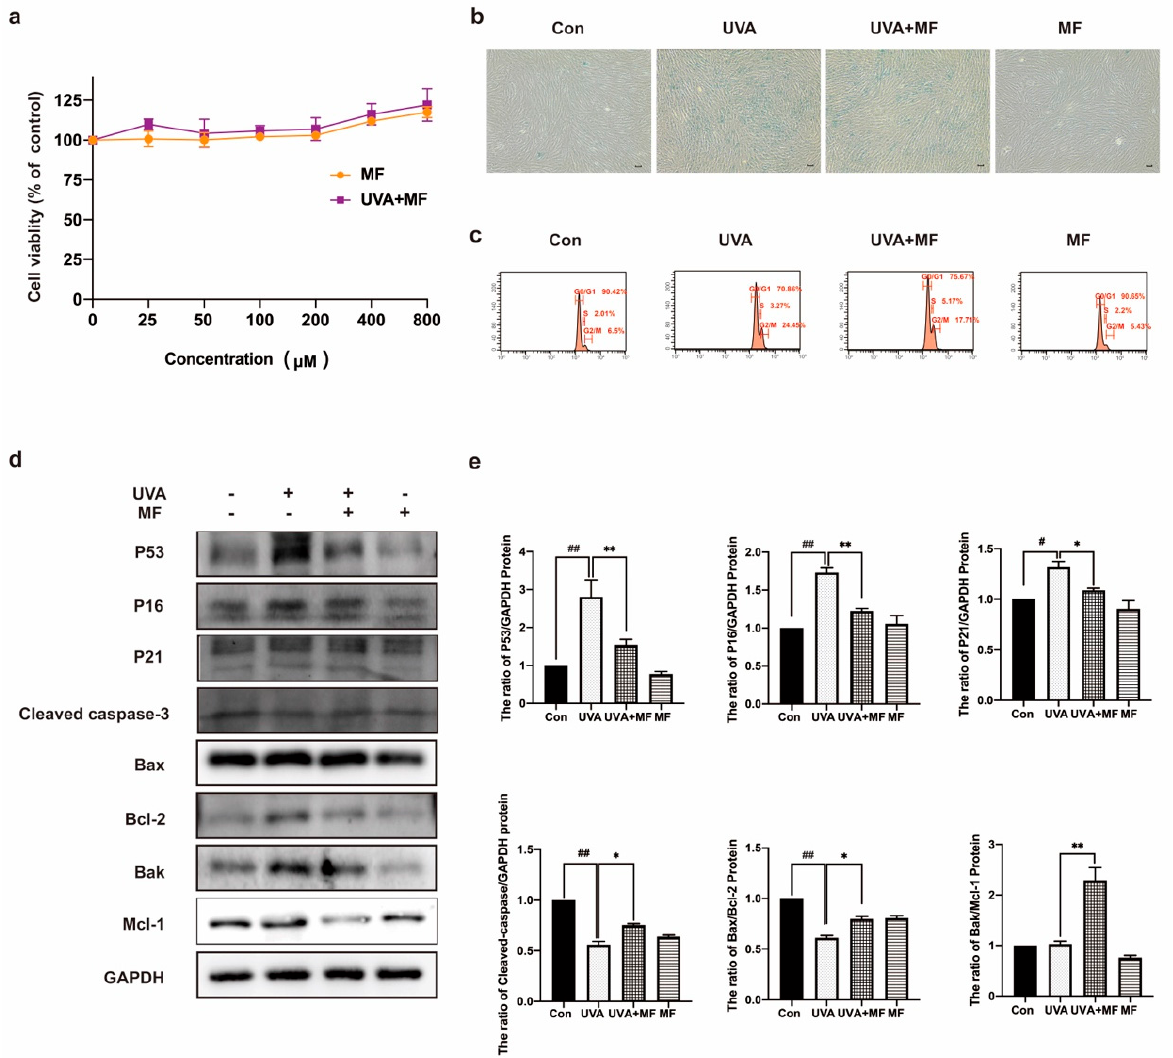
Figure 2. Metformin can ameliorate UVA-induced photoaging on HFFs. ( a ) HFFs were treated with metformin (0 − 800 μ M) alone or in combination with UVA, the cell viability of HFFs were detected by MTT assay. ( b ) Cells were treated with UVA alone or in combination with 100 µ M metformin, the activity of senescence-associated β -galactosidase and the percentage of cells positive for SA- β -gal activity (40 × ) were measured. ( c ) Cells were treated with UVA alone or in combination with 100 µ M metformin, flow cytometry system analysis was used to detect the phase of the cell cycle in cells. ( d , e ) Cells were treated with UVA alone or in combination with 100 µ M metformin, the protein levels of P53, P16, P21, cleaved caspase-3, Bax, Bcl − 2, Bak, Mcl − 1 were measured by western blot. Data are presented as mean ± SD, n = 3. # p < 0.05, ## p < 0.01 vs. control cells, * p < 0.05, ** p < 0.01 vs. UVA-treated